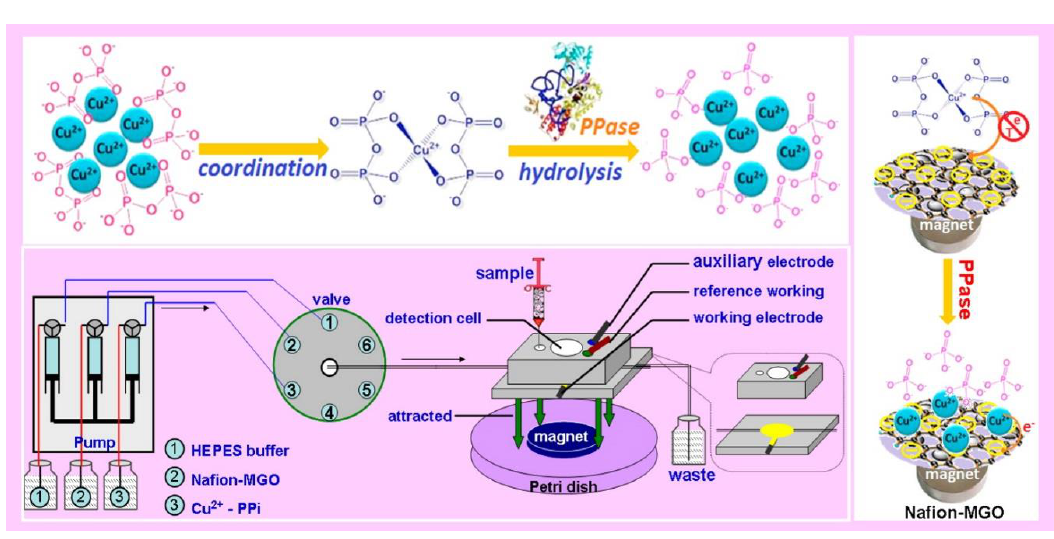
Figure 2. Schematic diagram of microfluidic chemical device for pyrophosphatase activity monitoring. Adapted with permission from ref. [55]. Copyright © 2015, American Chemical Society.